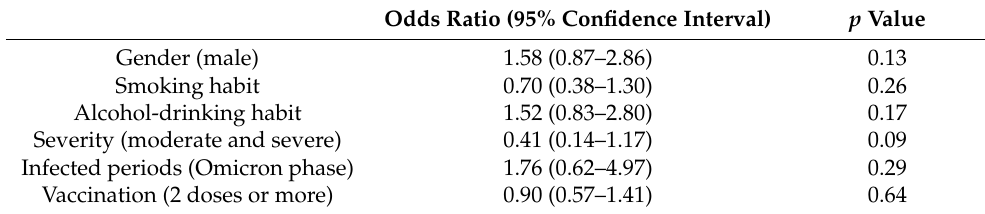
Figure 1. Percentage of patients with sleep disturbance in long COVID patients infected in each variant phase. ( A ) The percentage of long COVID patients with sleep disturbance in patients infected in each variant-based phase is shown. ( B ) Frequency of sleep disturbance in long COVID patients infected in each variant phase is shown. The preceding period was the period from the ancestral strain to the Alpha strain, before July 18, 2021; the Delta phase was the period from 19 July 2021 to 31 December 2021, when the Delta variants were dominant after the Alpha-dominant phase; and the Omicron phase was the period after 1 January 2022, when the Omicron variants were dominant in Okayama Prefecture, Japan. The χ 2 test was performed for each symptom between the groups and * p < 0.05 was considered as statistically significant. Table 2. Multivariate analysis to investigate factors associated with the sleep disturbance.